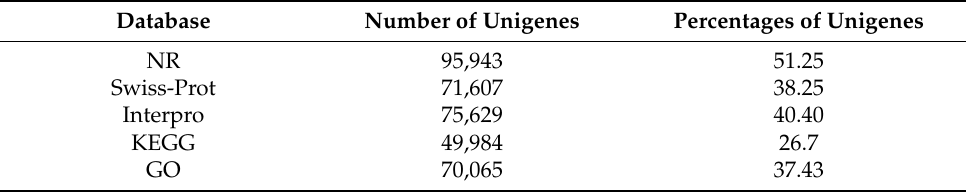
Figure 2. Distribution of the homology search of unigenes against the non-redundant (NR) protein database, ( A ) E-value distribution of the top Blastx hits against the NR database for each unigene; ( B ) Similarity distribution of the top Blastx hits against the NR database for each unigene. Table 2. Statistics of annotation results against public databases.